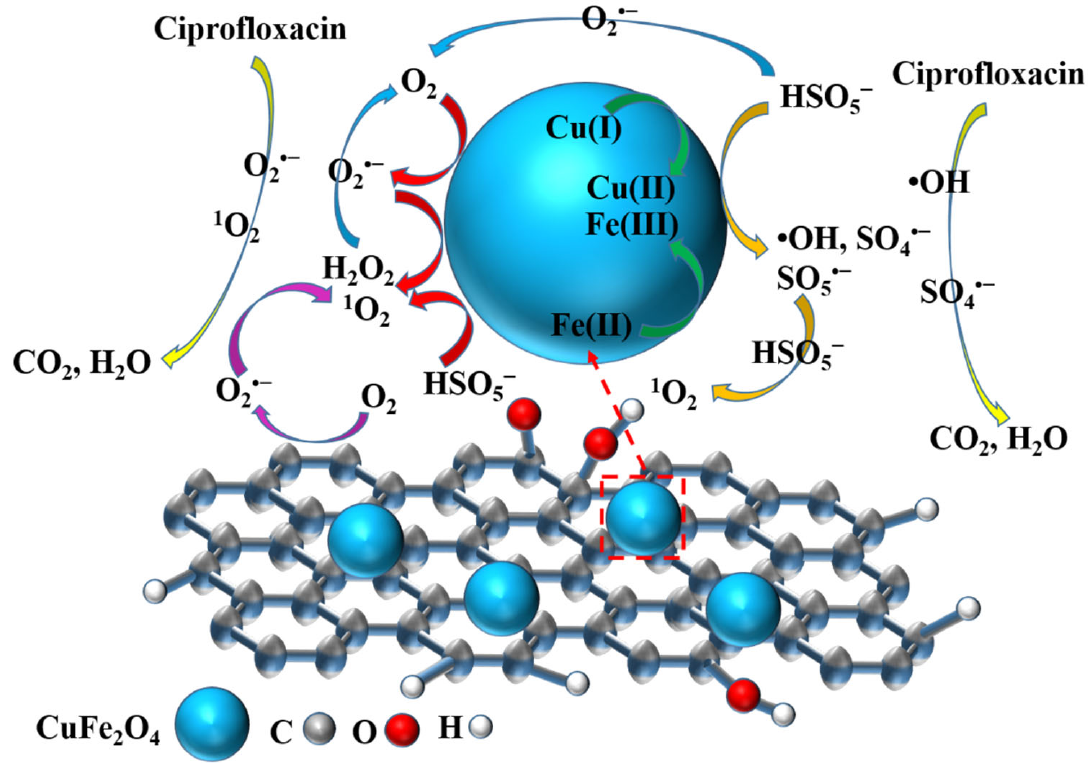
Figure 8. Proposed degradation mechanism of CuFe 2 O 4 @BC/PMS system.